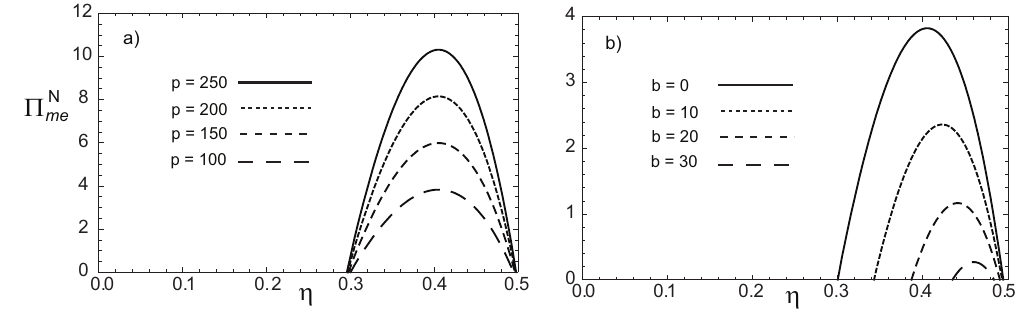
Figure 4. Profits function (cid:5) N in terms of the engine’s efficiency η with a Newton heat me transfer law for a) b = 0 and taking several values of p and b) p = 100 and taking several values of b